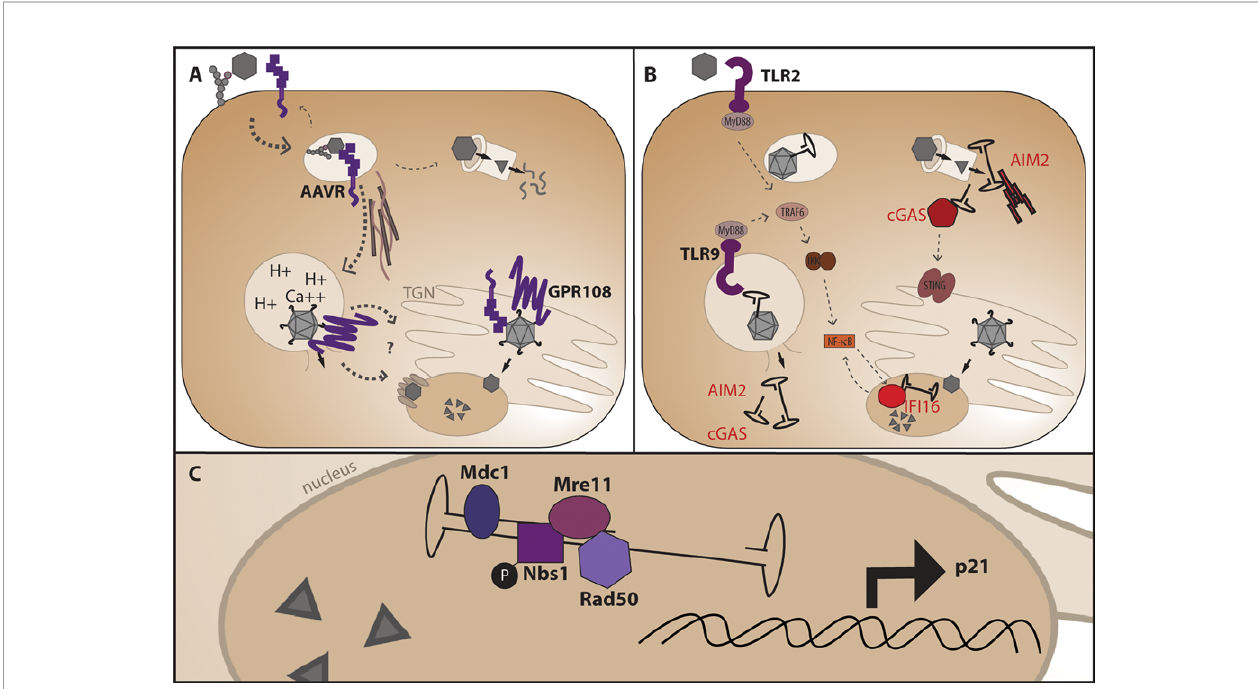
FIGURE 3 | AAV entry mechanism and points at which genome release may trigger DNA-speci fi c pattern recognition receptors. (A) After glycan attachment, the AAV capsid is endocytosed and binds the conserved cellular receptor AAVR, is traf fi cked along microtubules for productive infection through the endosomal system and TGN (below), or non-productive infection and degradation through the proteasome. Endosomal acidi fi cation and potentially other ions such as calcium facilitate a conformational change in capsid which releases the VP1 portion of capsid for interaction with the conserved entry factor GPR108 prior to nuclear import. (B) Where the genome is fi rst sensed in the cell may dictate the cellular response and alter viability of HSPCs. Non-productive infection and capsid degradation through the proteasome may leave cytoplasmic AAV genomes available for recognition by AIM2 leading to apoptosis, or cGAS leading to NF- k B signaling via the adaptor protein STING. Genome extrusion in endosomes may activate TLR2 and/or TLR9 causing NF- k B activation via MyD88 signaling, and aberrant endosomal escape may also allow sensing by AIM2 or cGAS. Nuclear AAV genomes may be sensed by the nuclear DNA sensor IFI16 causing subsequent NF- k B signaling. (C) Nuclear DNA damage response proteins known to interact with the AAV genome during second-strand synthesis or expressed in response to AAV